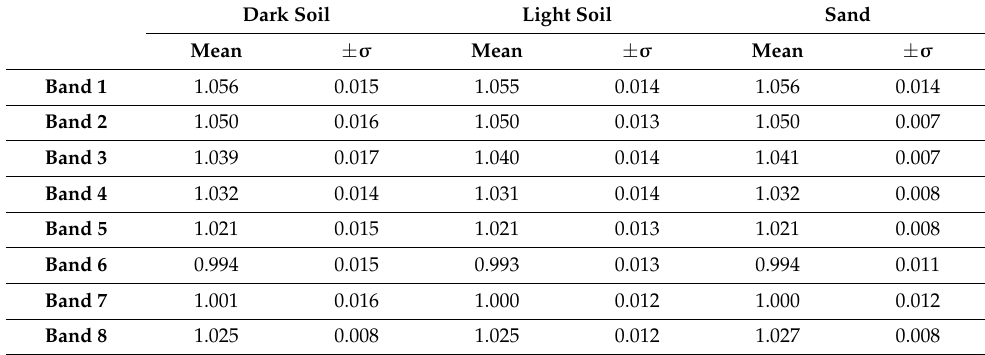
Table 4. Barren land cover types cross-calibration gain reflectance values.